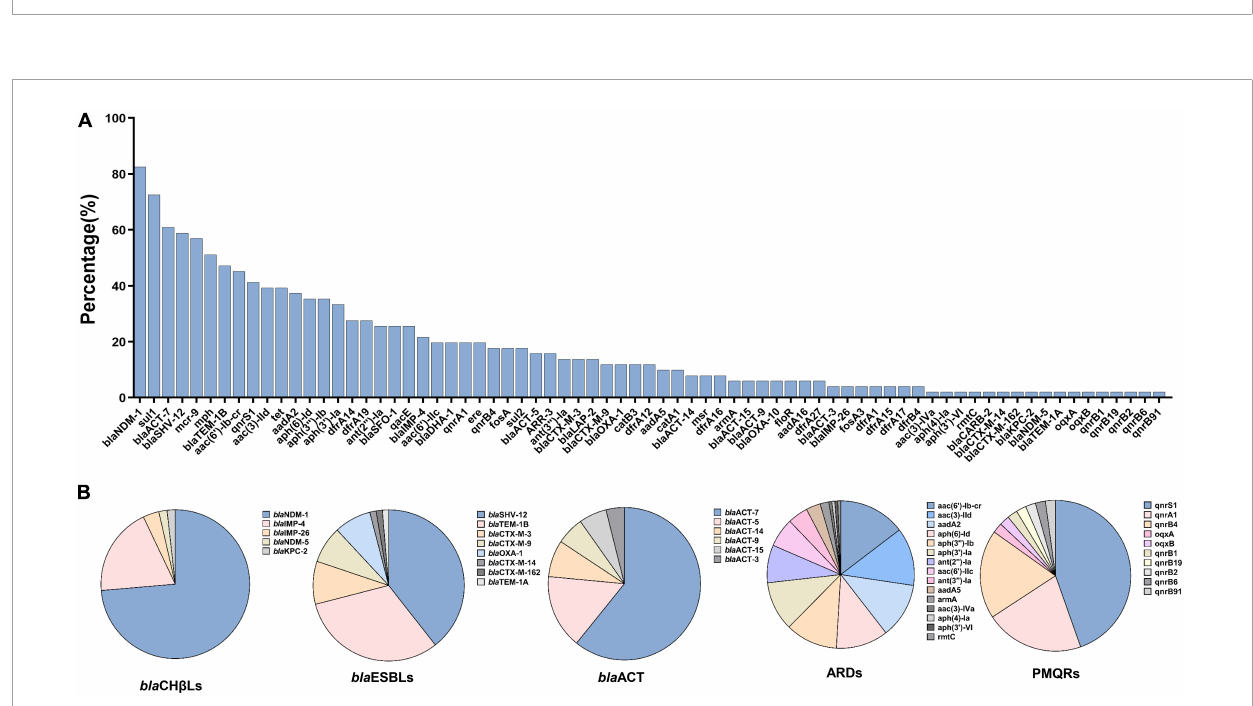
FIGURE2 Antimicrobial resistance genes and the detailed subtypes detected among 51 carbapenem-resistant Enterobacter cloacae complex isolates. (A) Distribution of antimicrobial resistance genes ranked by the percentages. (B) The detailed subtypes of some predominant resistance genes. bla CH β Ls, carbapenem-hydrolyzing β -lactamases; bla ESBLs, extended-spectrum β -lactamases; ARDs, aminoglycoside resistant determinants; PMQRs, plasmid mediated quinolone resistance